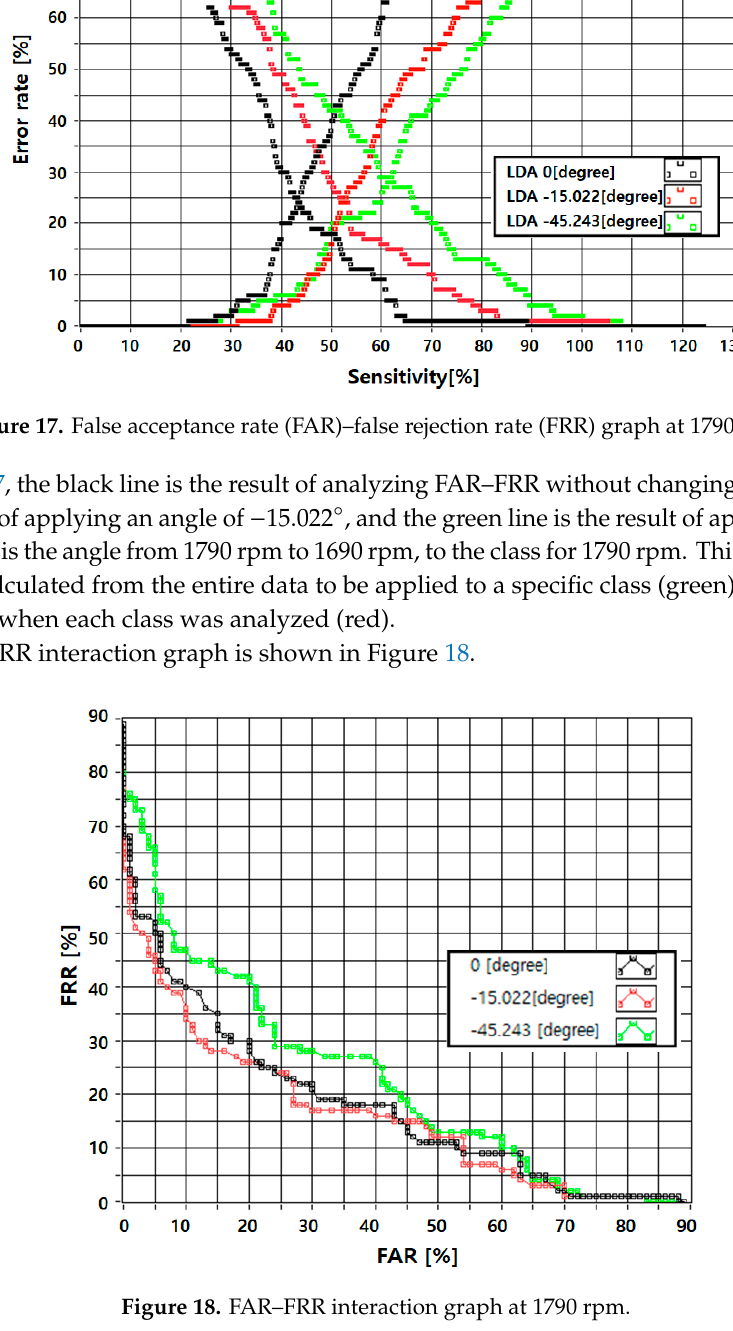
Figure 18. FAR–FRR interaction graph at 1790 rpm.